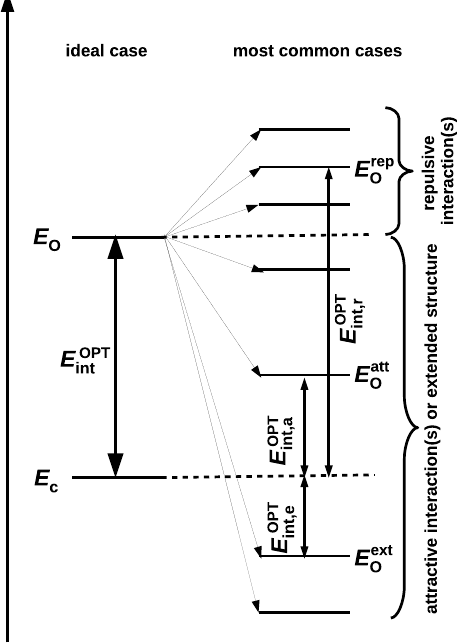
Figure 5. Scheme showing the presence of a new either repulsive or attractive interaction as a cause of either overestimating or underestimating the determined value of the intramolecular interaction